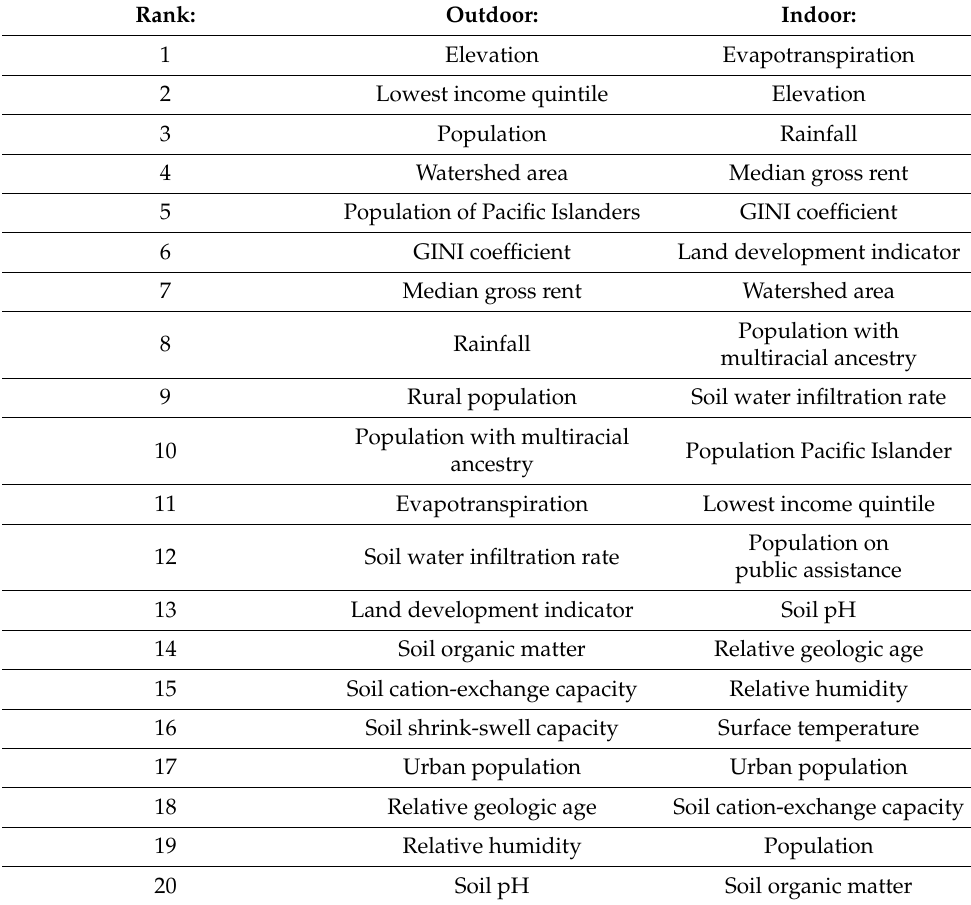
Table 3. Variance importance ranks of geospatial layers calculated from the machine learning method applied separately to outdoor and indoor